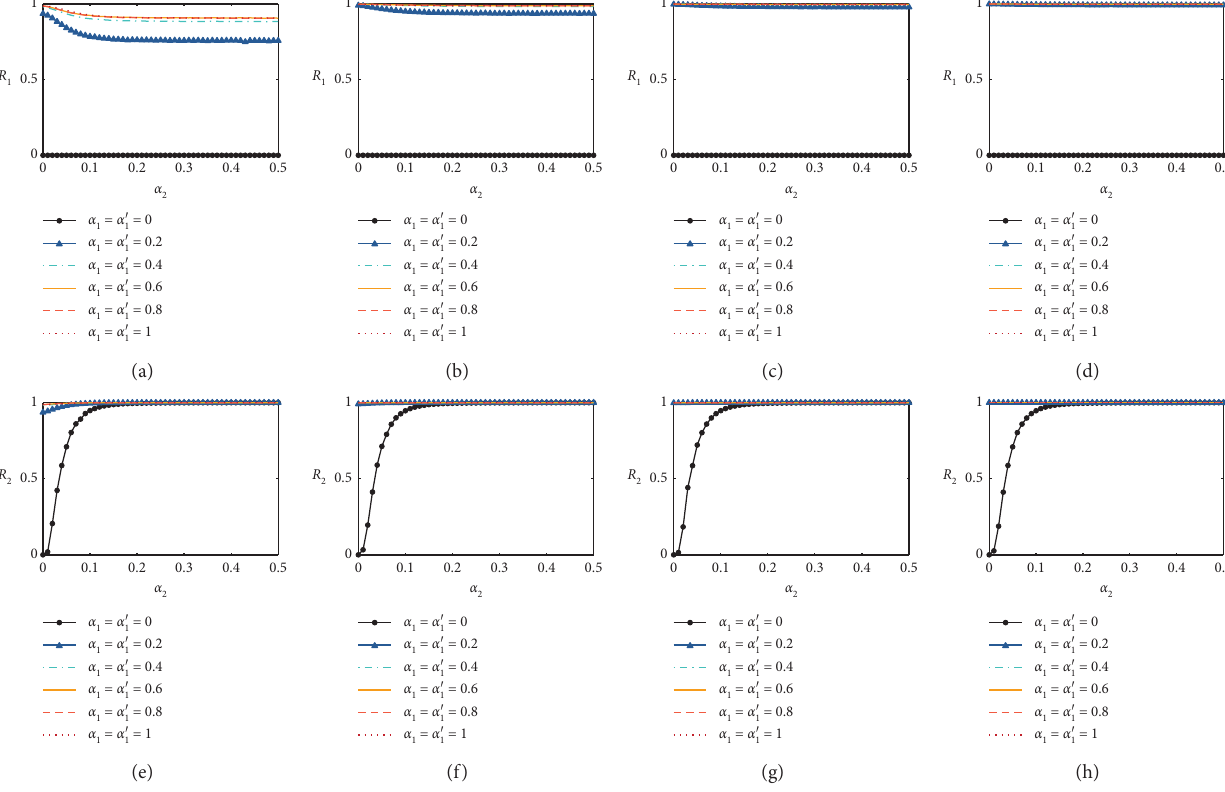
Figure 4: Virus spreading size R with (a) λ parameters are set to be c